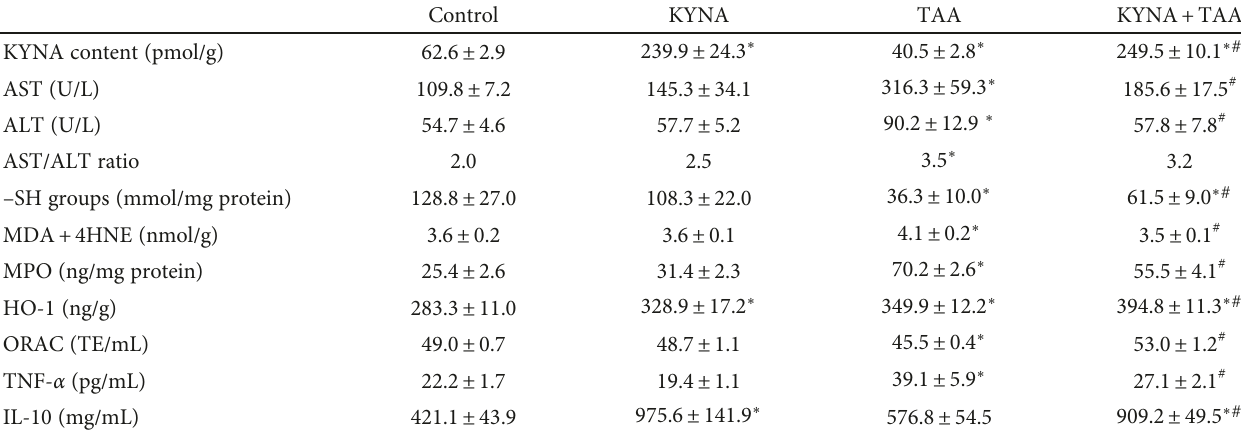
Table 2: E ff ect of kynurenic acid (KYNA) on biochemical parameters in thioacetamide (TAA) induced liver injury in